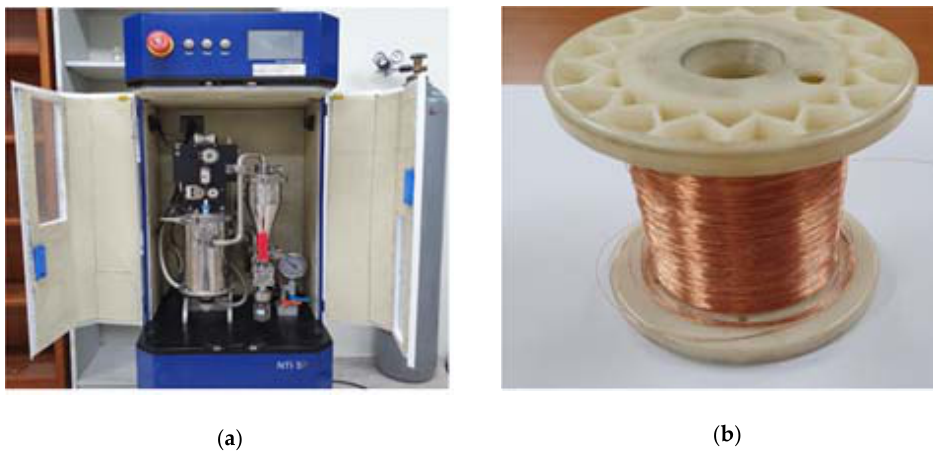
Figure 1. Pursed wire evaporation (PWE) equipment used to manufacture nano powder: ( a ) photograph of PWE equipment and ( b ) photograph of copper metal wire used in PWE equipment.